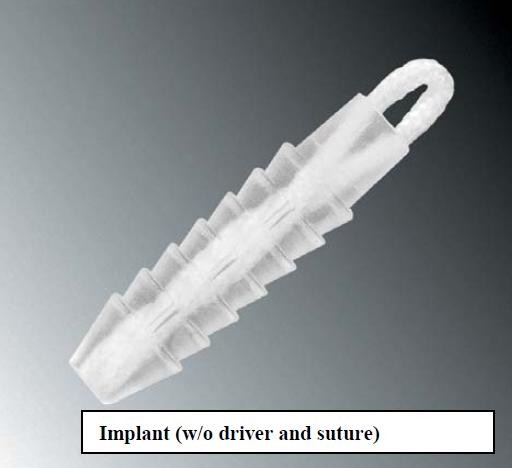
Demonstrates the suture anchor used.